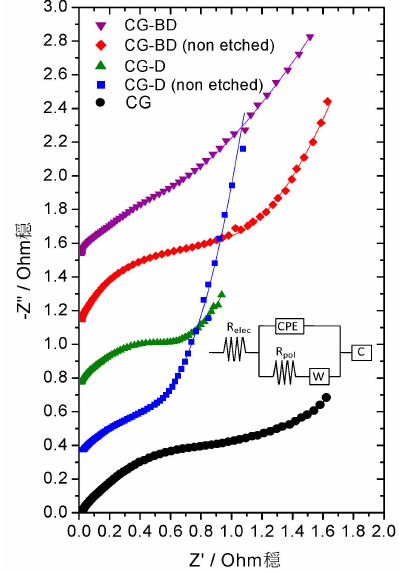
Figure 9. Nyquist plots derived from impedance spectra recorded for the diatomite treated carbon aerogels and carbon aerogel used as a blank sample (for clarity purposes, the curves have been shifted by 0.4 units in the ordinate axis). Inset: Equivalent circuit applied to the fitting of the impedance